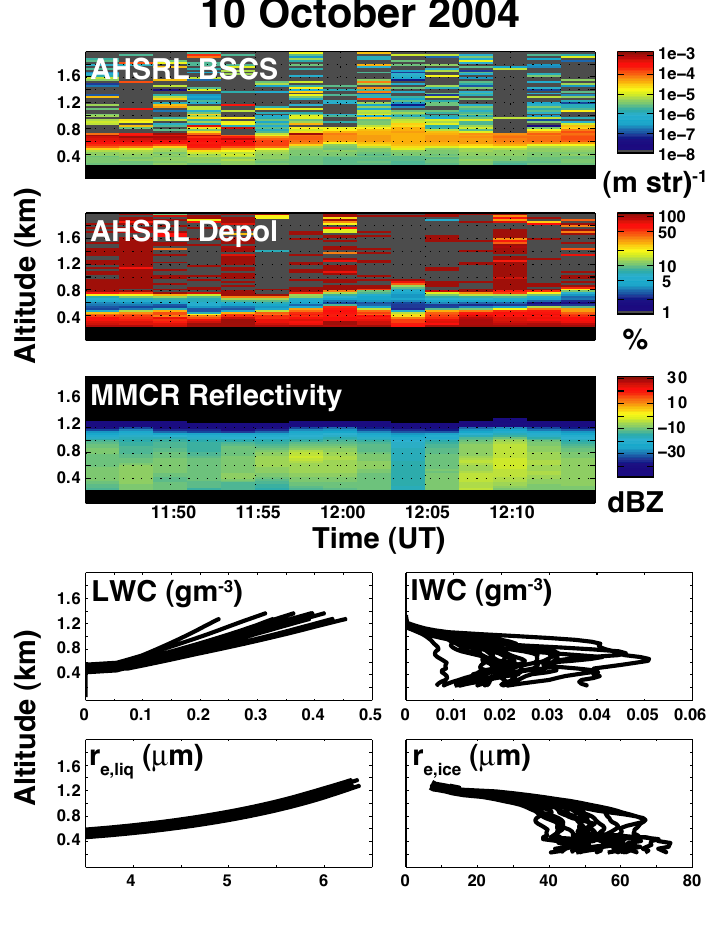
Fig. 1. Measured and retrieved cloud properties on 10 October, 2004. Included are (top to bottom) AHSRL bacscatter cross-section, AHSRL depolarization ratio, MMCR reflectivity, and profiles of liquid water content (LWC), ice water content (IWC) and liquid (r e,liq ) and ice (r e,ice ) effective particle sizes.